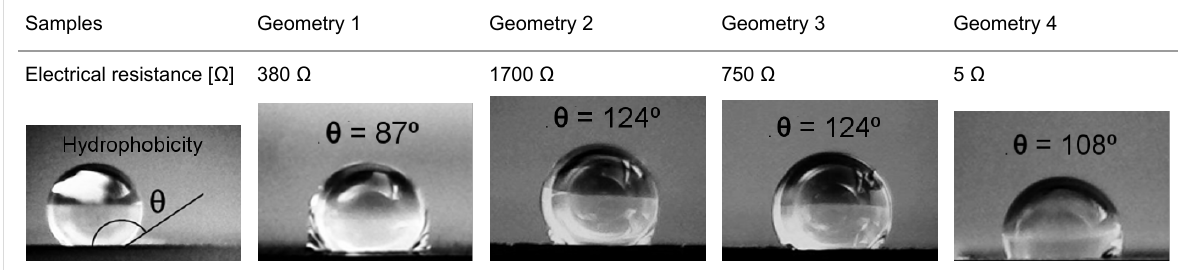
Table 2: Electrical resistance and hydrophobicity of the Au nanostructures produced under different geometries. Samples